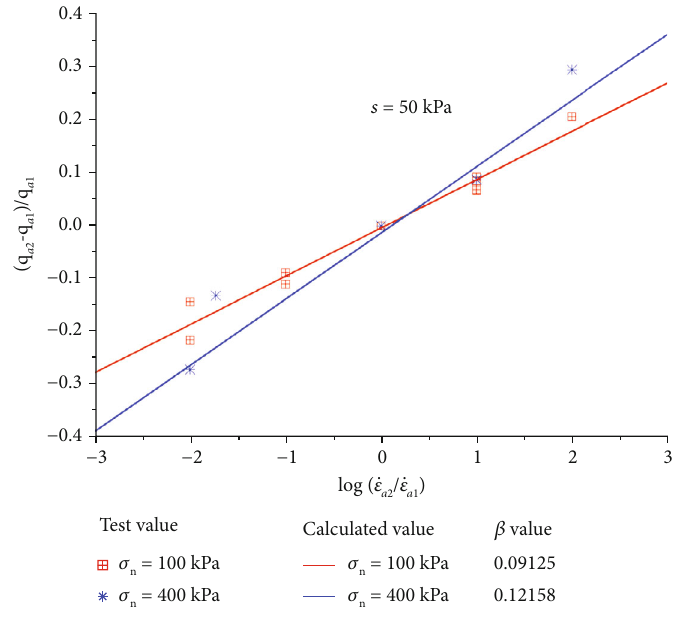
Figure 12: β value of reticulate red clay with di ff erent con fi ning pressure ( s = 50 kPa